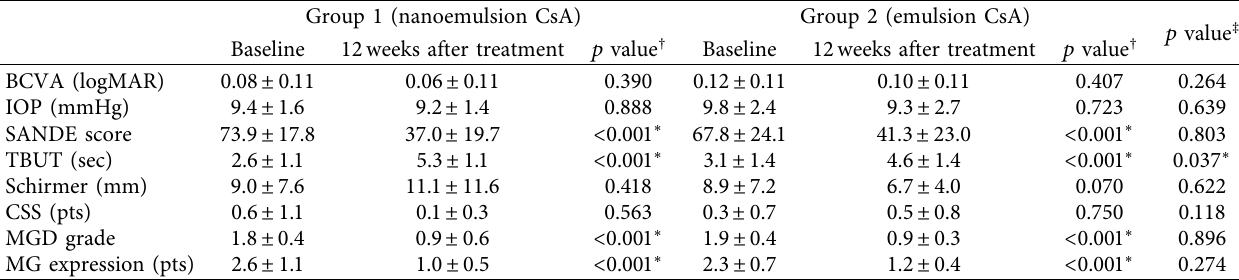
Table 3: Comparison of therapeutic effects at 12 weeks after treatment with topical FML and CsA between nanoemulsion and emulsion CsA groups.